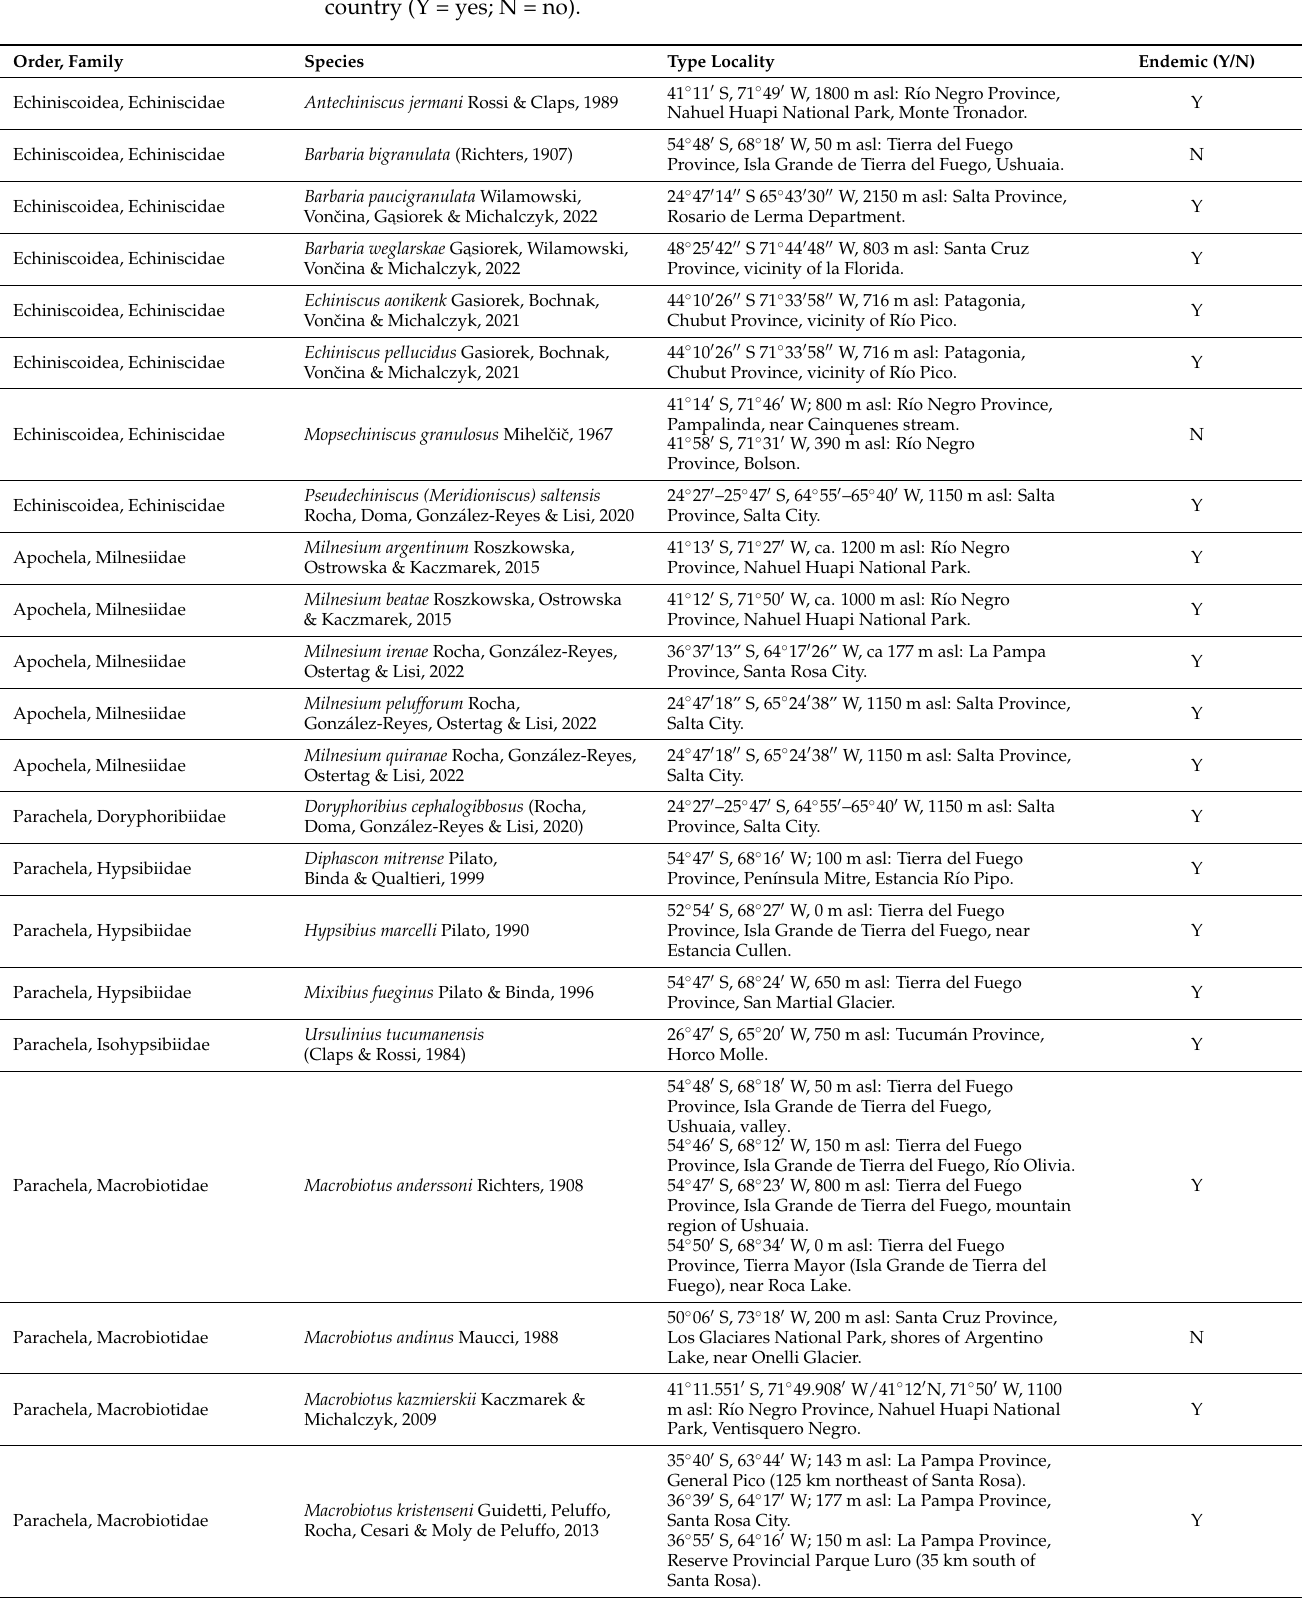
Table 2. Species with locus typicus in Argentina, indicating if the species is currently endemic for the country (Y = yes; N =